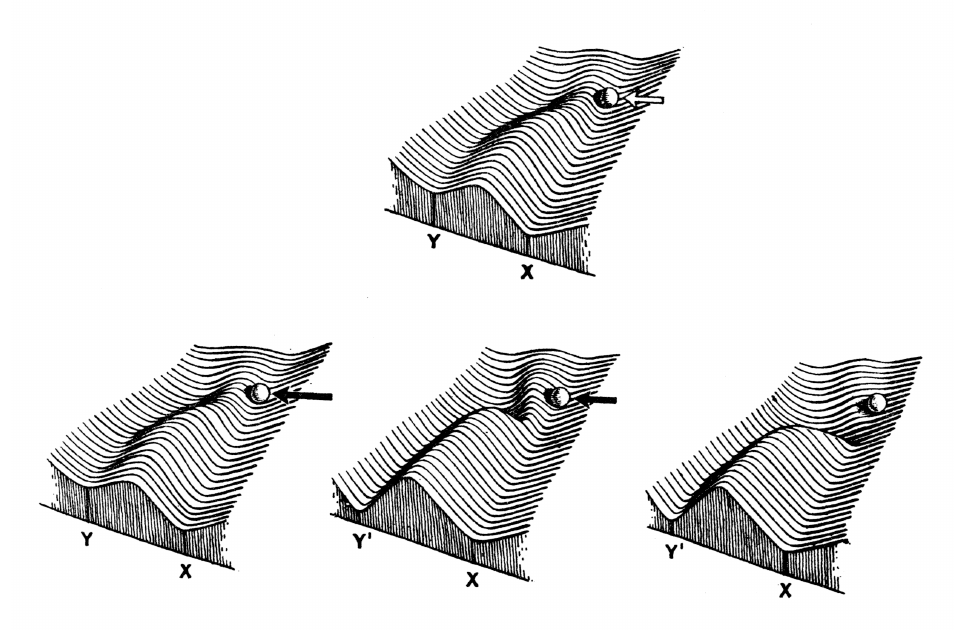
'Organic Selection' (the Baldwin Effect) and Genetic Assimilation , from Conrad H. Waddington, The Strategy of the Genes (London: Allen and Unwin, 1957), 167 (photo: